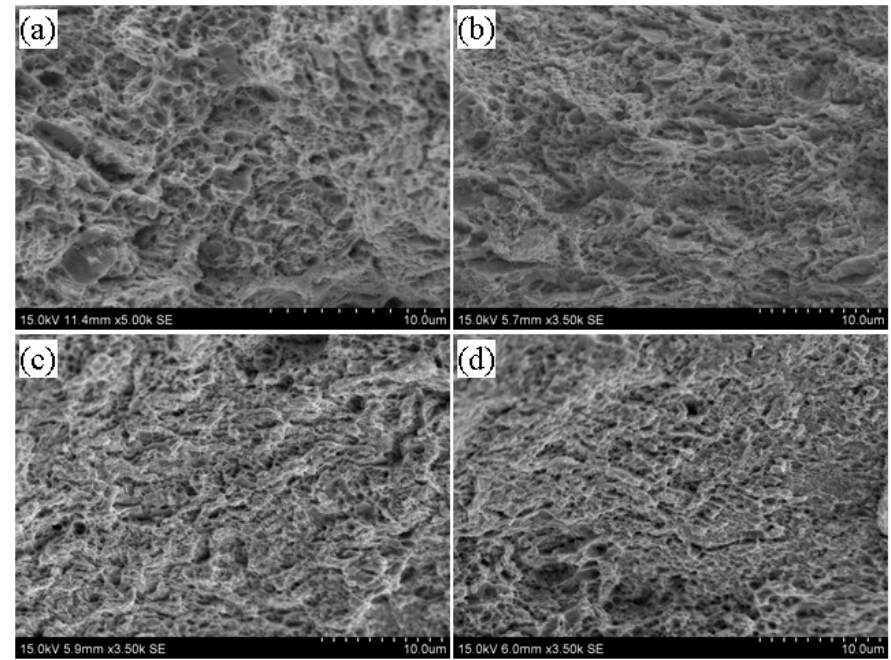
Figure 8. Fracture morphology of tempered 5140 alloy steel before and after tempering at 480 °C ( a ) 0 Protons/cm 2 ( b ) 2 × 10 14 Protons/cm 2 ( c ) 2 × 10 15 Protons/cm 2 ( d ) 2 × 10 16 Protons/cm 2 .